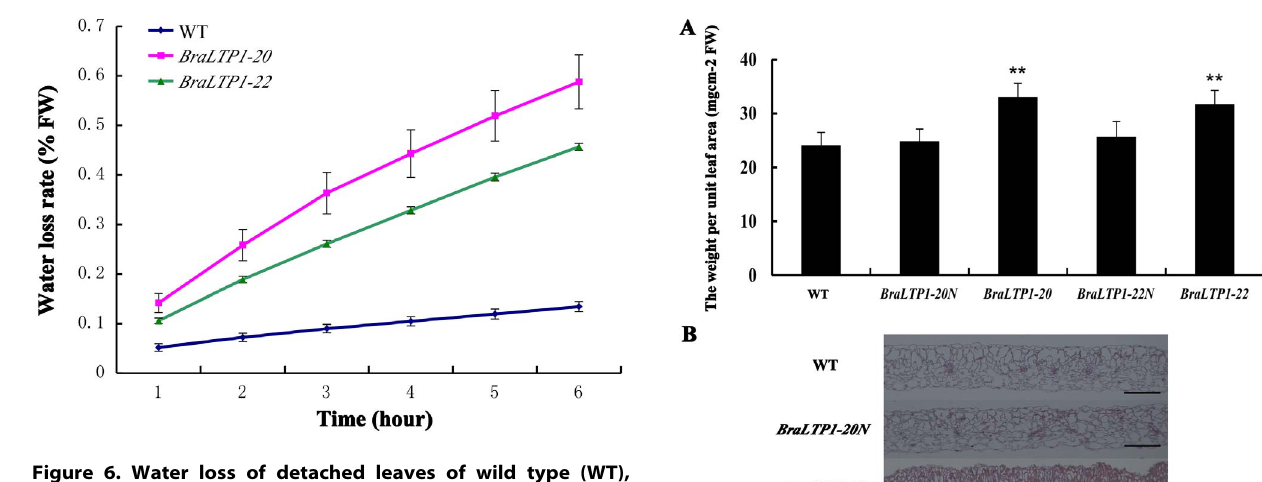
Figure 6. Water loss of detached leaves of wild type (WT), BraLTP1-20 and BraLTP1-22 plants. The data are the means 6 SD of three replicates ( n = 5 for each experiment); P , 0.01 (ANOVA, P=6.53 6 10 2 56 ).